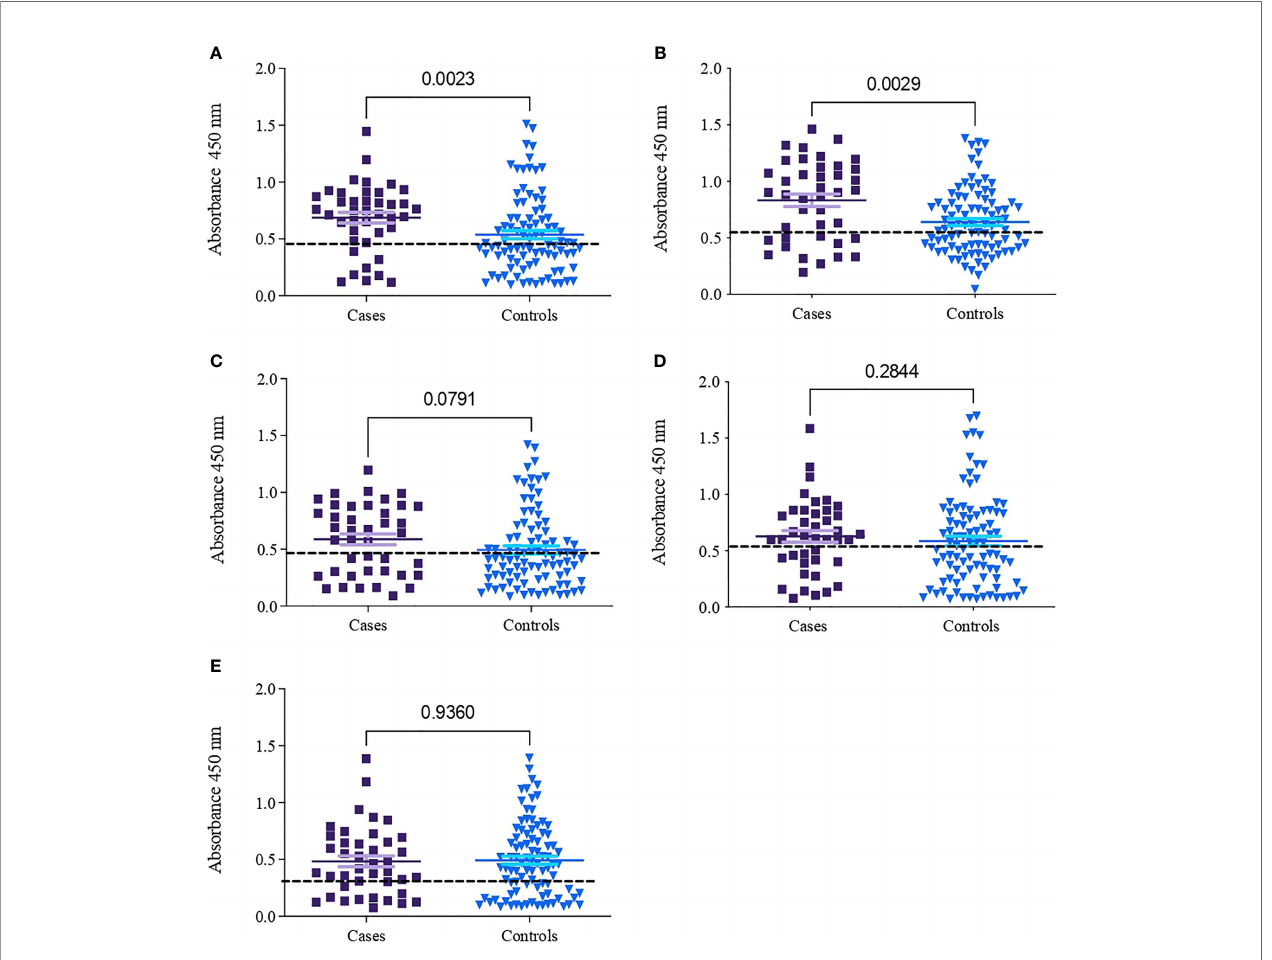
FIGURE 1 | Absorbances obtained between cases and controls for four peptides of the Cryptosporidium parvum proteins gp15 and gp40. (A) A133; cutoff line (0.46). (B) A32; cutoff line (0.57). (C) R61; cutoff line (0.47). (D) A109; cutoff line (0.55). (E) V30; cutoff line